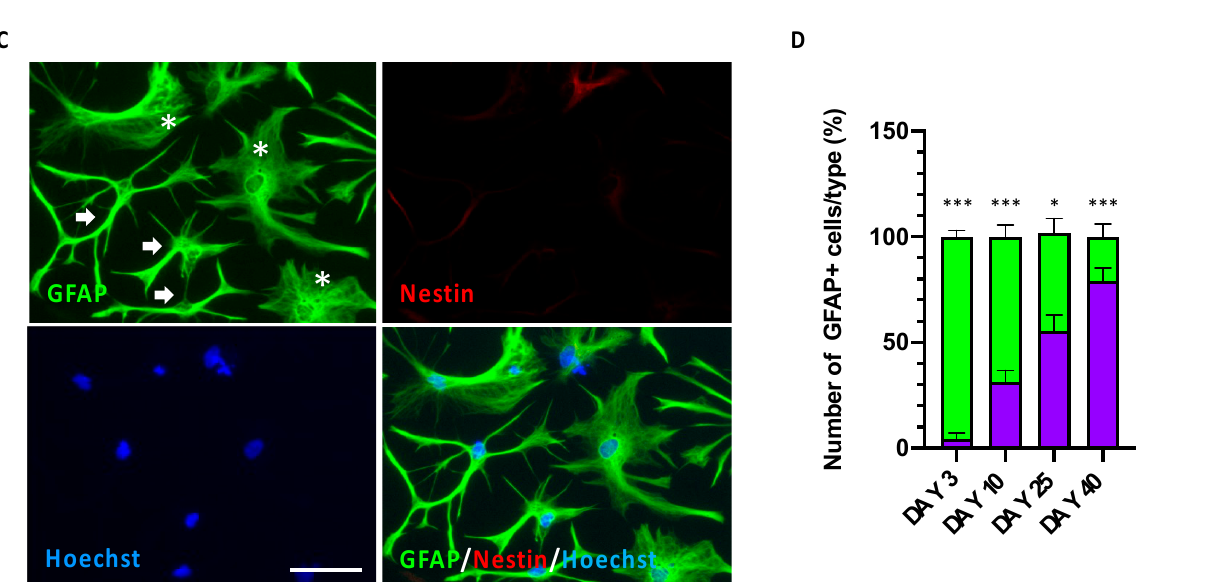
Figure 3. Long-term maintained in culture CX Astrocytes exhibited time-dependent maturation. ( A ) Representative immunofluorescence pictures of CX APC cultures at DIV 40 of exposure to AMM-SFM. Cultures were stained for Nestin and GFAP expression. Nuclei were stained with Hoechst. Scale bar: 75 µ m. ( B ) Graph showing the percentage of GFAP + /Nestin − (astrocytes) and GFAP + /Nestin + (APCs) cells in DIV 40 cultures exposed to AMM-FBS (purple bars) or AMM-SFM (green bars). The percentage was normalized over the total number of cells assessed by Hoechst staining. Data were expressed as the means ± STDV ( n = 3 biologically independent experiments). p < 0.01 (**), and not significant (ns) according to Student’s t-test analysis. ( C ) Representative immunofluorescence pictures of CX APC cultures at DIV 40 of exposure to AMM-SFM in which it is possible to observe the two typical morphologically distinct flat fibrous-like morphology and flat fibrous-like astrocyte populations. Cultures were stained for Nestin and GFAP expression. Nuclei were stained with Hoechst. Asterisks indicated astrocytes with flat fibrous-like morphology; arrows indicated astrocytes with protoplastic/reactive morphology. Scale bar: 75 µ m. ( D ) Graphs reporting the number of GFAP + /Nestin − (astrocytes) cells with flat fibrous-like morphology (purple) or with protoplastic/reactive morphology (green) in CX APC cultures exposed for 3, 10, 25 and 40 DIV to AMM-SFM. The percentage was normalized over the total number of GFAP + /Nestin − (astrocytes) cells. Data were expressed as the means ± STDV ( n = 3 biologically independent experiments). p < 0.05 (*), p < 0.001 (***) and not significant (ns) according to Student’s t ‐ test analysis.